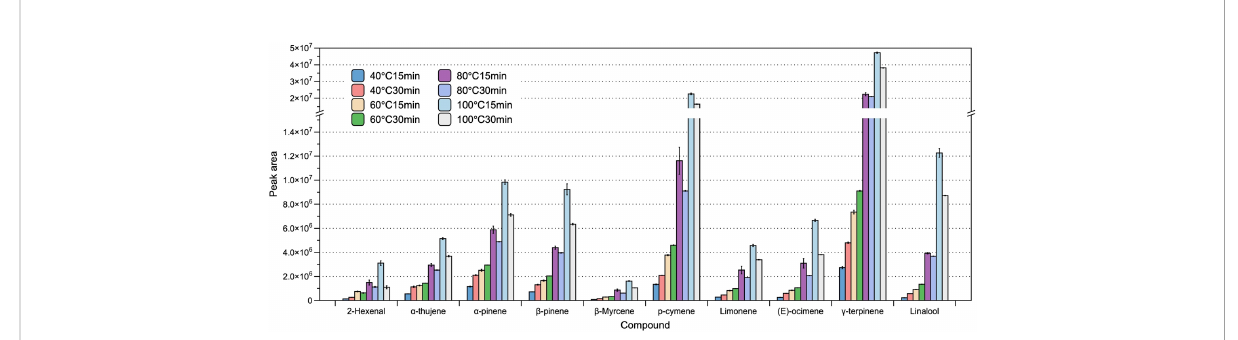
FIGURE 2 The effect of heating temperature and incubation time on the ef fi ciency of headspace extraction of volatile compounds. The bars and error bars respectively denote the means and 95% con fi dence intervals of three biological replicates. Compounds on the x-axis are listed in order of their sequence of elution, with corresponding peak areas shown on the